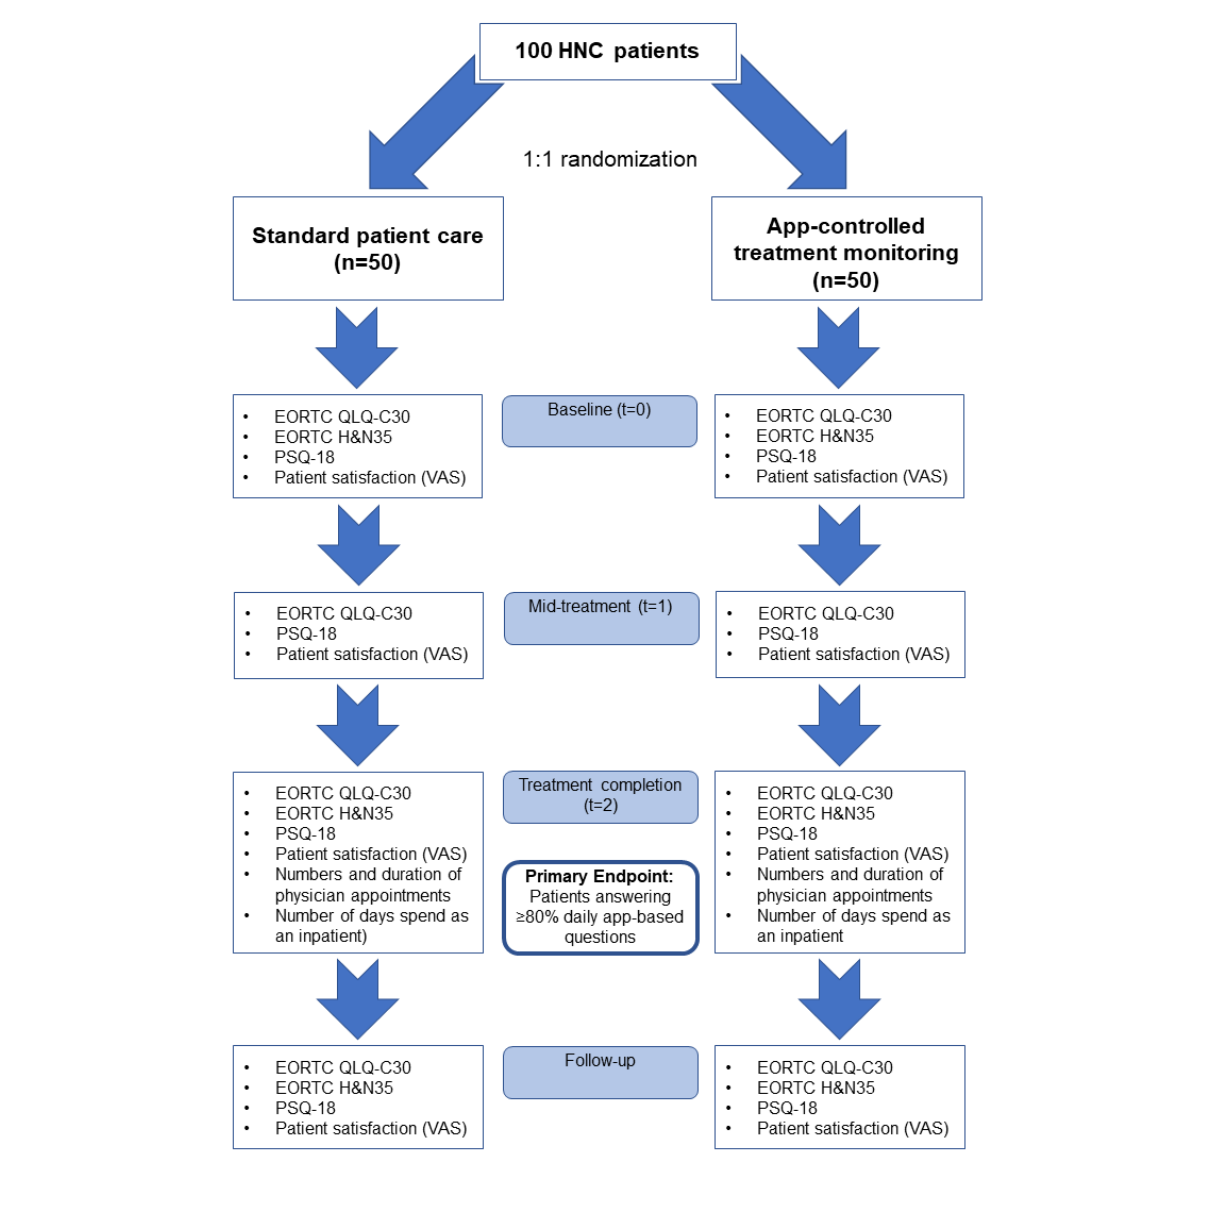
Figure 1. Flow chart outlining the study design and the timeline for the individual trial endpoints. HNC: head and neck cancer; VAS: visual